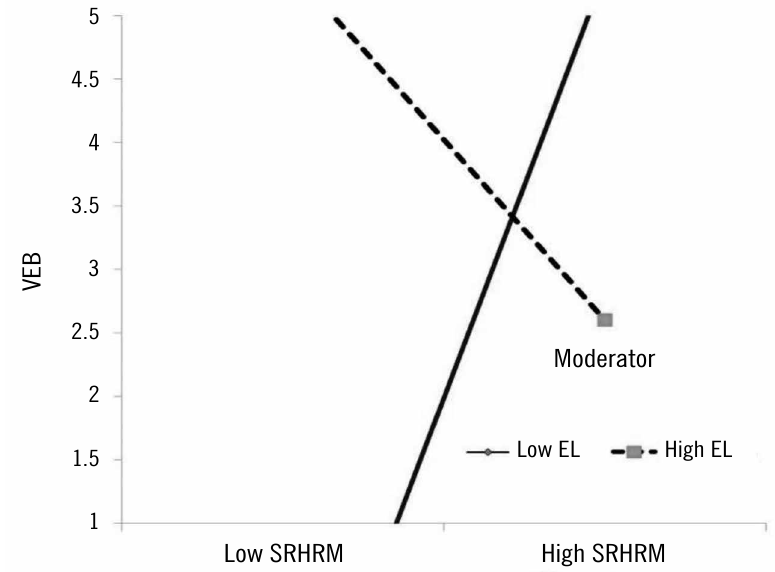
Figure 2. Moderating effect of ecocentric